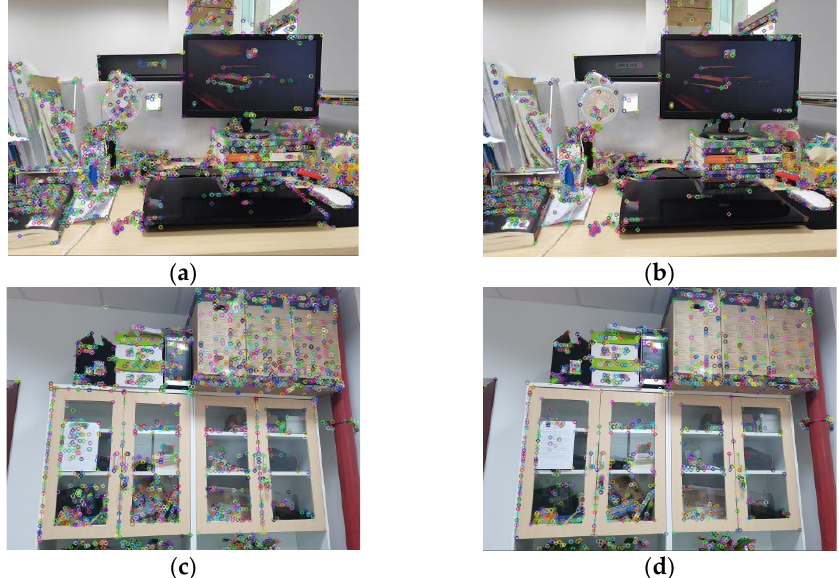
Figure 9. The extraction results of two algorithms on real indoor scenes: ( a , b ) desktop images, ( c , d ) locker images. Images ( a , c ) show the distribution of the point features extracted by the MA algorithm, and images ( b , d ) show the distribution of the feature points extracted by the improved algorithm in this paper. The colored circles are the extracted point features.